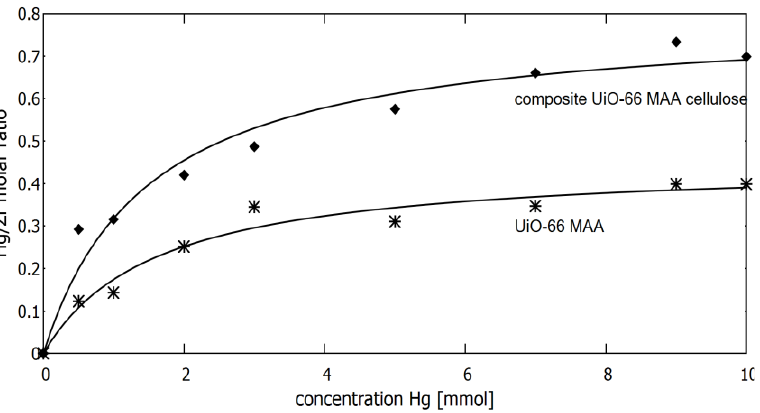
Figure 6. Sorption isotherms and their approximation with the Langmuir model for UiO-66_MAA sorbent and their composite with cellulose.